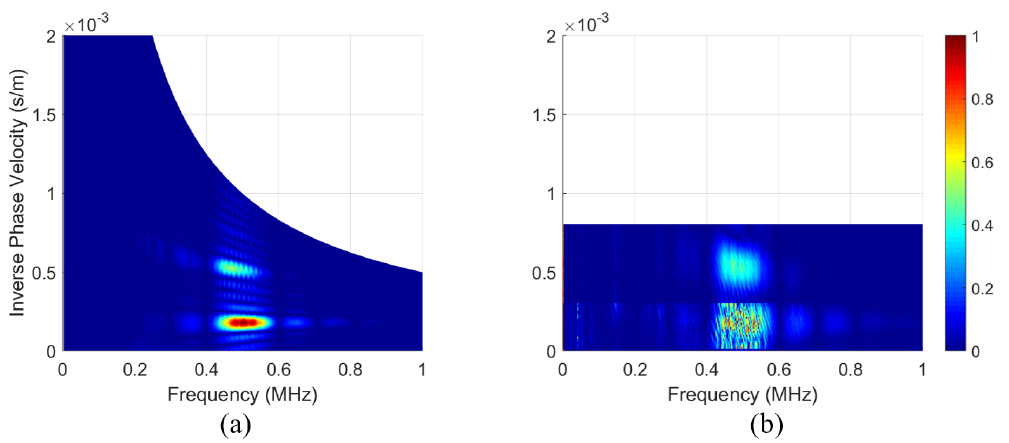
Figure 10. ( a ) Normalized inverse phase velocity–frequency spectrum that was measured using the PVDF transducer; and ( b ) rescaled, then normalized inverse phase velocity–spectrum that was measured using the air-coupled